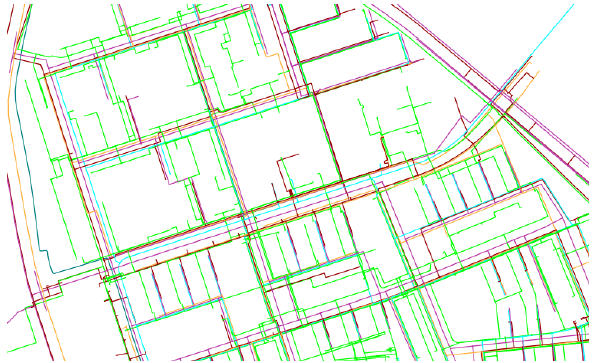
Figure 3. Representation of a the input datasets used in this work. Electrical network (in red) and sewer-system network (in purple) of the city of Rotterdam.